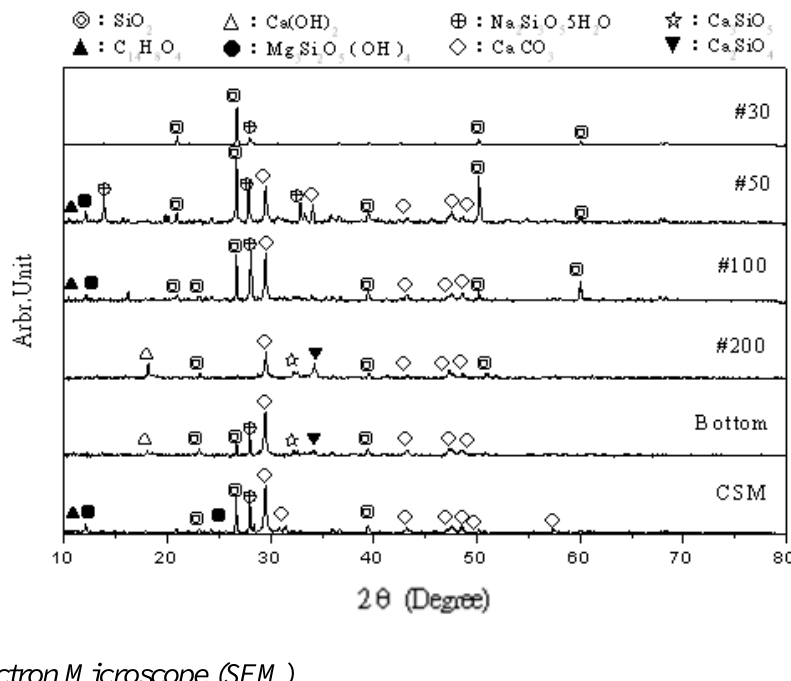
Figure 9. XRD of Various sieves of substances mixing with